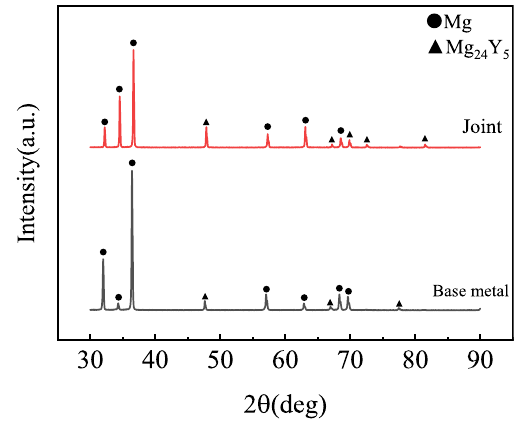
Fig. 6 DSC curve of WE43 magnesium alloy